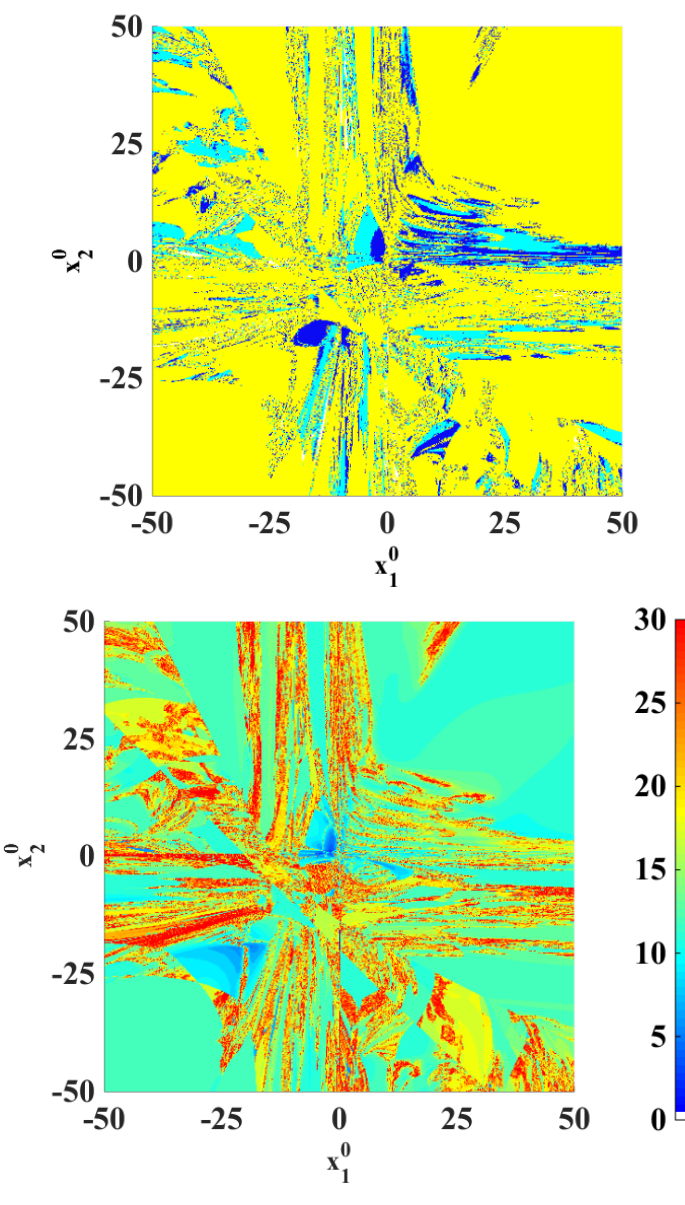
Figure 5. Basins of attraction ( upper ) and number of iterations ( lower ) for the fourth-order system when the factored method with m = 10 + 5 i is